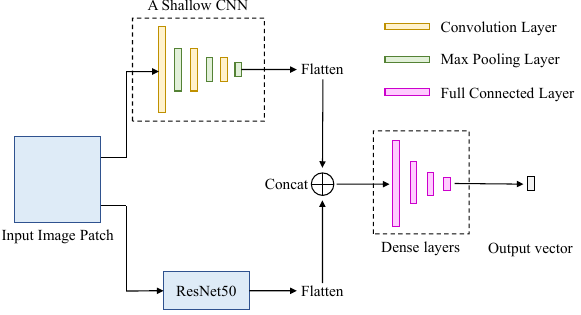
Figure 4. Architecture of